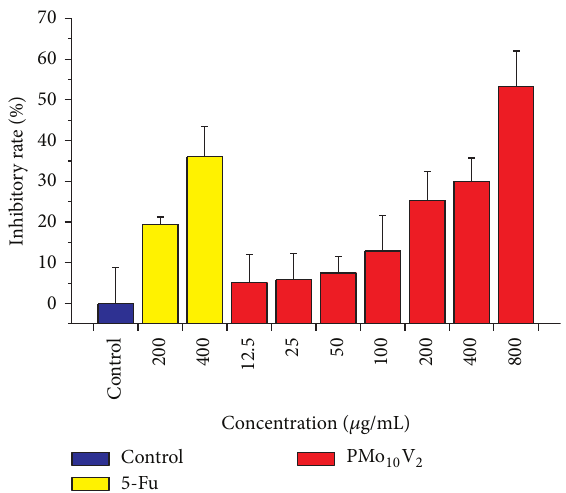
Figure 2: The inhibitor effect of control group, 5-Fu groups, and PMo 10 V 2 groups on Hela cells.